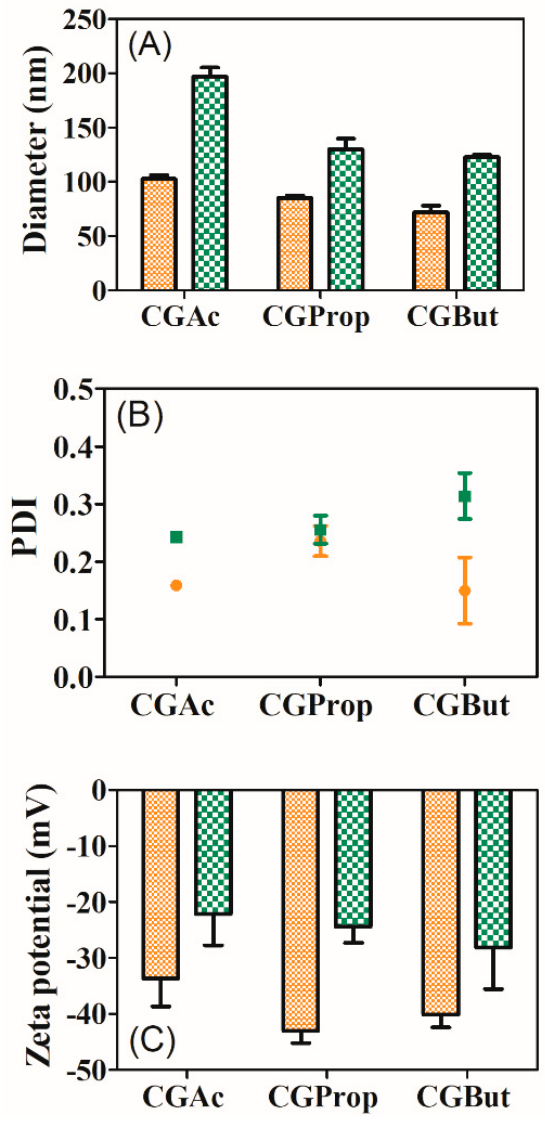
Figure 3. Hydrodynamic diameter ( A ), PDI ( B ), and zeta potential ( C ) for unloaded and AmB-loaded nanoparticles. Unloaded nanoparticles (orange) and AmB-loaded nanoparticles (green). Particle diameters for the unloaded nanoparticles were 103 ± 4; 85 ± 2, and 72 ± 6 nm for CGAc, CGProp, and CGBut nanoparticles, respectively (Figure 3A). A decrease in particle size with increasing of anhydride chain length was observed, a fact that may be due to the higher interaction among the hydrophobic polysaccharide chains, which led to the observed decrease in particle size. Particle sizes were found to be smaller for acylated nanoparticles in comparison to unmodified gum (225 ± 22 nm).